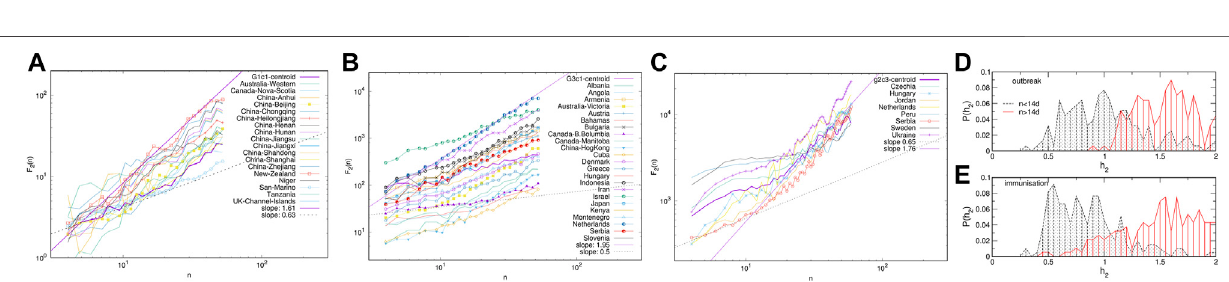
FIGURE5| Centroidsofclustersc1toc5,foundforthreegroupsG1,G2andG3,intheoutbreakphasenetwork (A) ,andgroupsg1,g2andg3intheimmunisation phase network (B) . In each panel, the number of countries and provinces belonging to that cluster is shown in brackets; the smooth red line represents the centroid ’ s trend.The topleft panel ineach fi gure shows the fl uctuationsfunction F 2 ( n ) vs .segmentlength n for theidenti fi ed trends; theslope h 2 = 2isindicated bythedashed line.